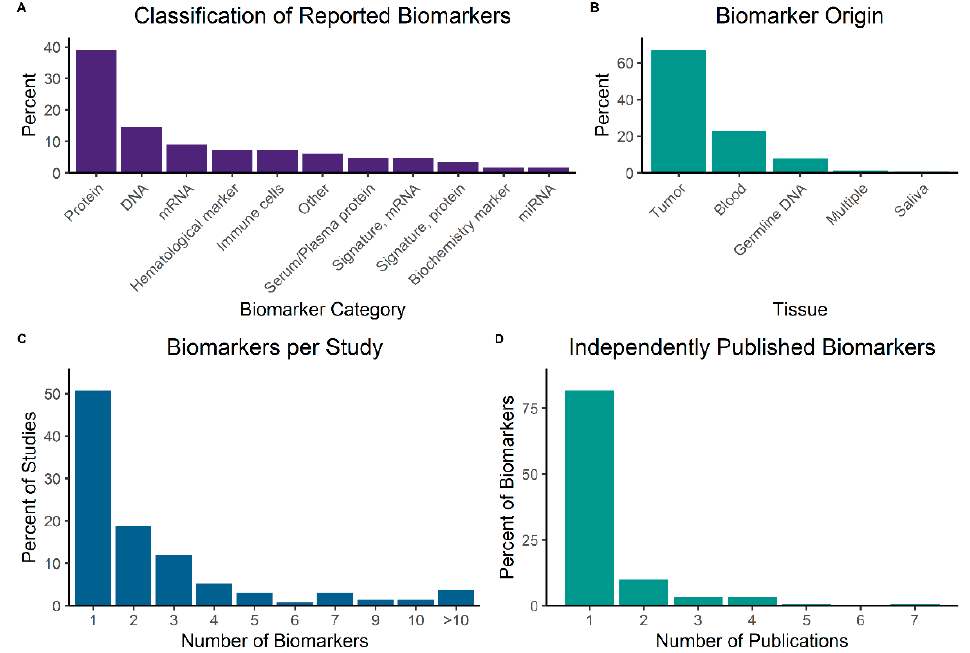
Figure 4. Distribution of biomarkers among categories ( A ). Tissue of origin for biomarkers ( B ). Number of assessed biomarkers per included study ( C ). Number of independent publications per biomarker ( D ).